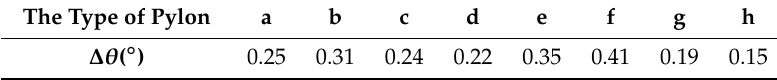
Table 8. The result of precision verification about pylon redirection.